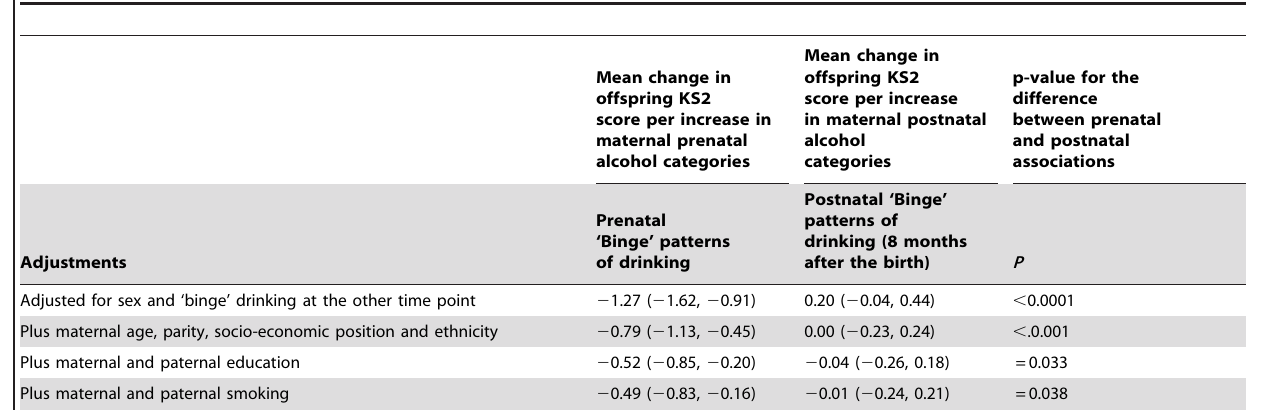
Table 5. Mean change in offspring KS2 score per increase in maternal alcohol categories during and after